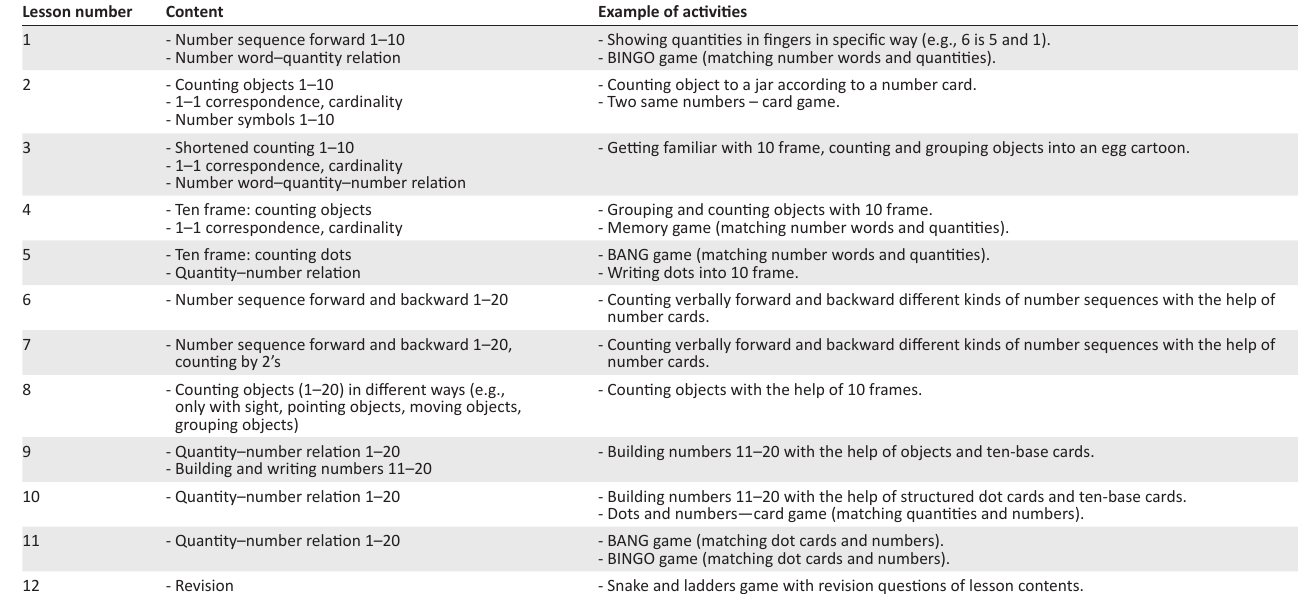
TABLE 1-A1: Content of the counting skills intervention